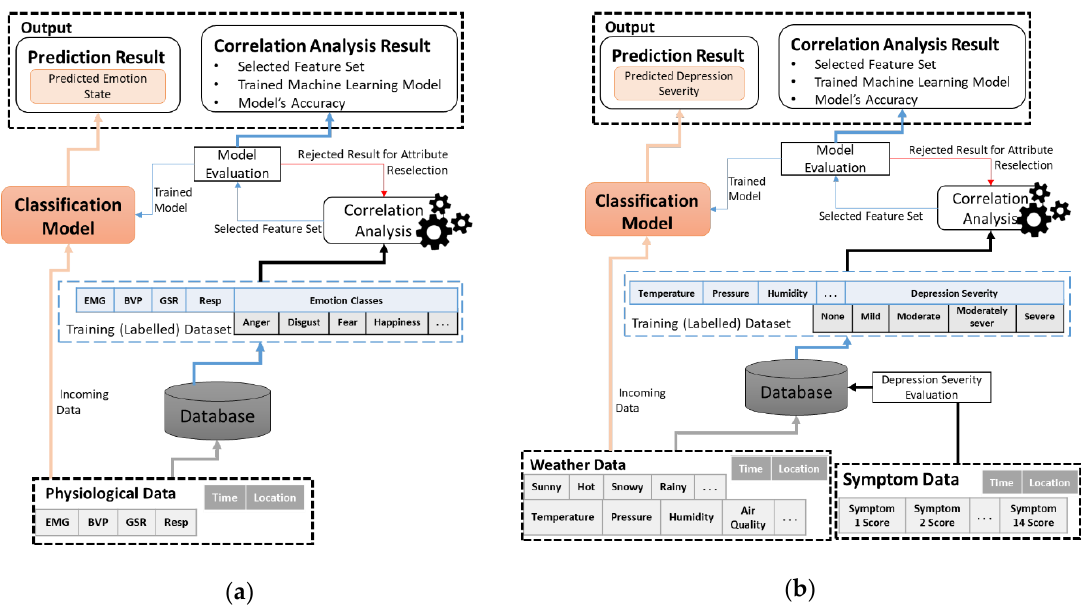
Figure 3. Process flow of Data Analytics: ( a ) Emotion detection. ( b ) Identifying depressive disorder severity.